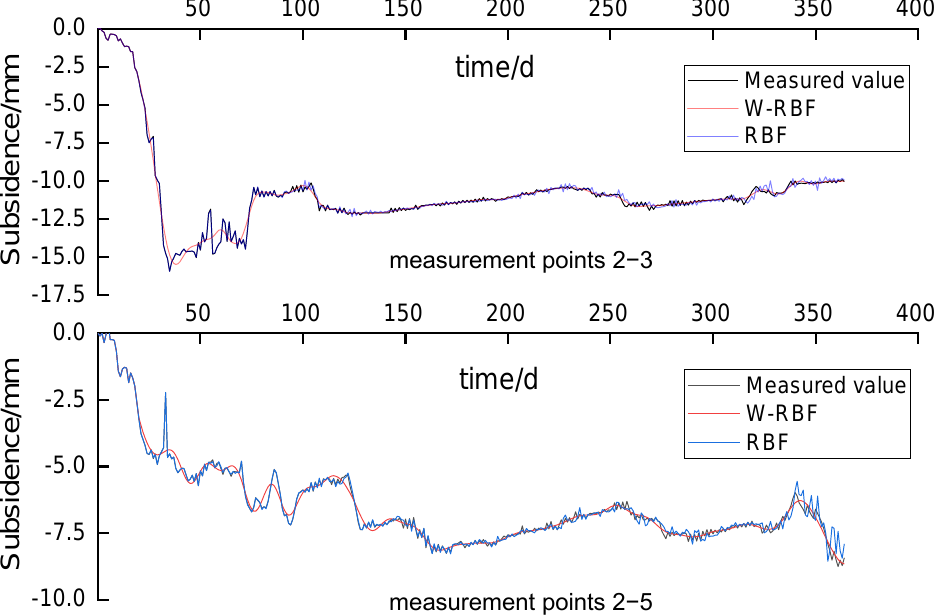
Figure 8. Comparison of error curves at points 2 − 3 and points 2 − 5. A new prediction model is put forward according to the data change pattern of the error comparison chart Figure 8. According to the images, it can be found that the error of the simulated data of measuring points 2 − 5 suddenly increased around the 25th day. Ac- cording to the analysis of the original data, the monitoring data suddenly increased on the 33rd day, and the monitoring settlement value returned to the original level on the 34th day. It is guessed that this is due to the error caused by the construction process or the surrounding environment, and the actual settlement value has not changed so much.